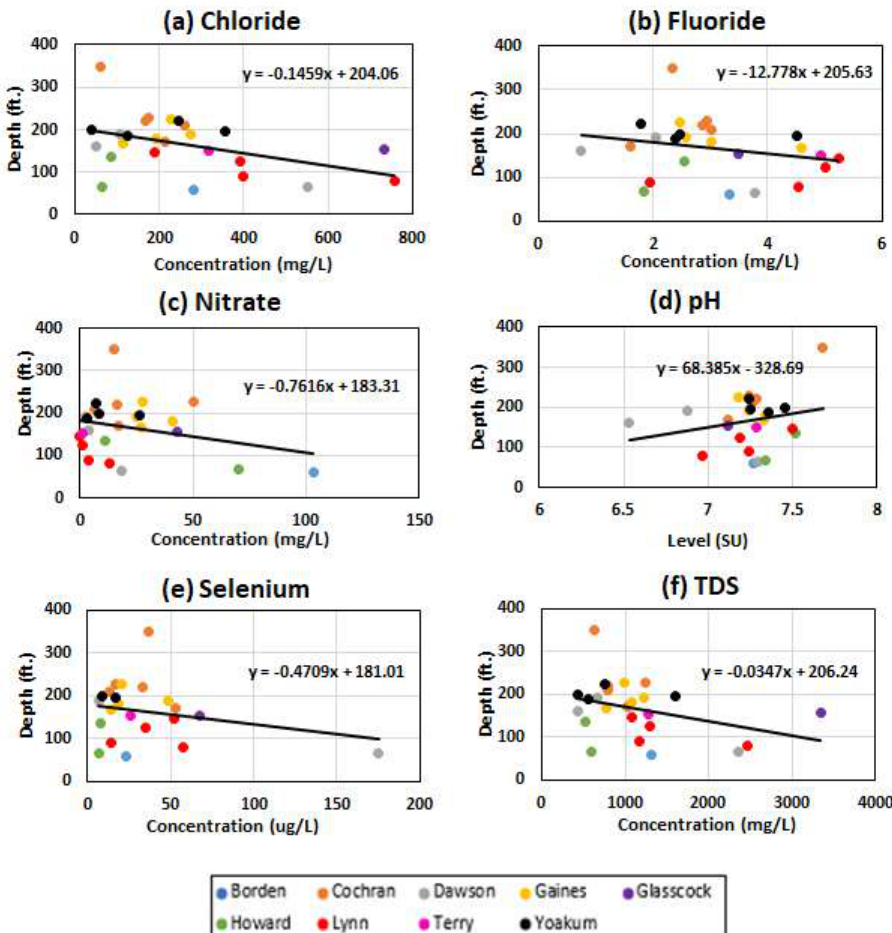
Figure 12. The latest data available for ( a ) chloride, ( b ) fluoride, ( c ) nitrate, ( d ) pH, ( e ) selenium, and ( f ) TDS values versus well depth for each county excluding Garza County during the research period 1990–2016.